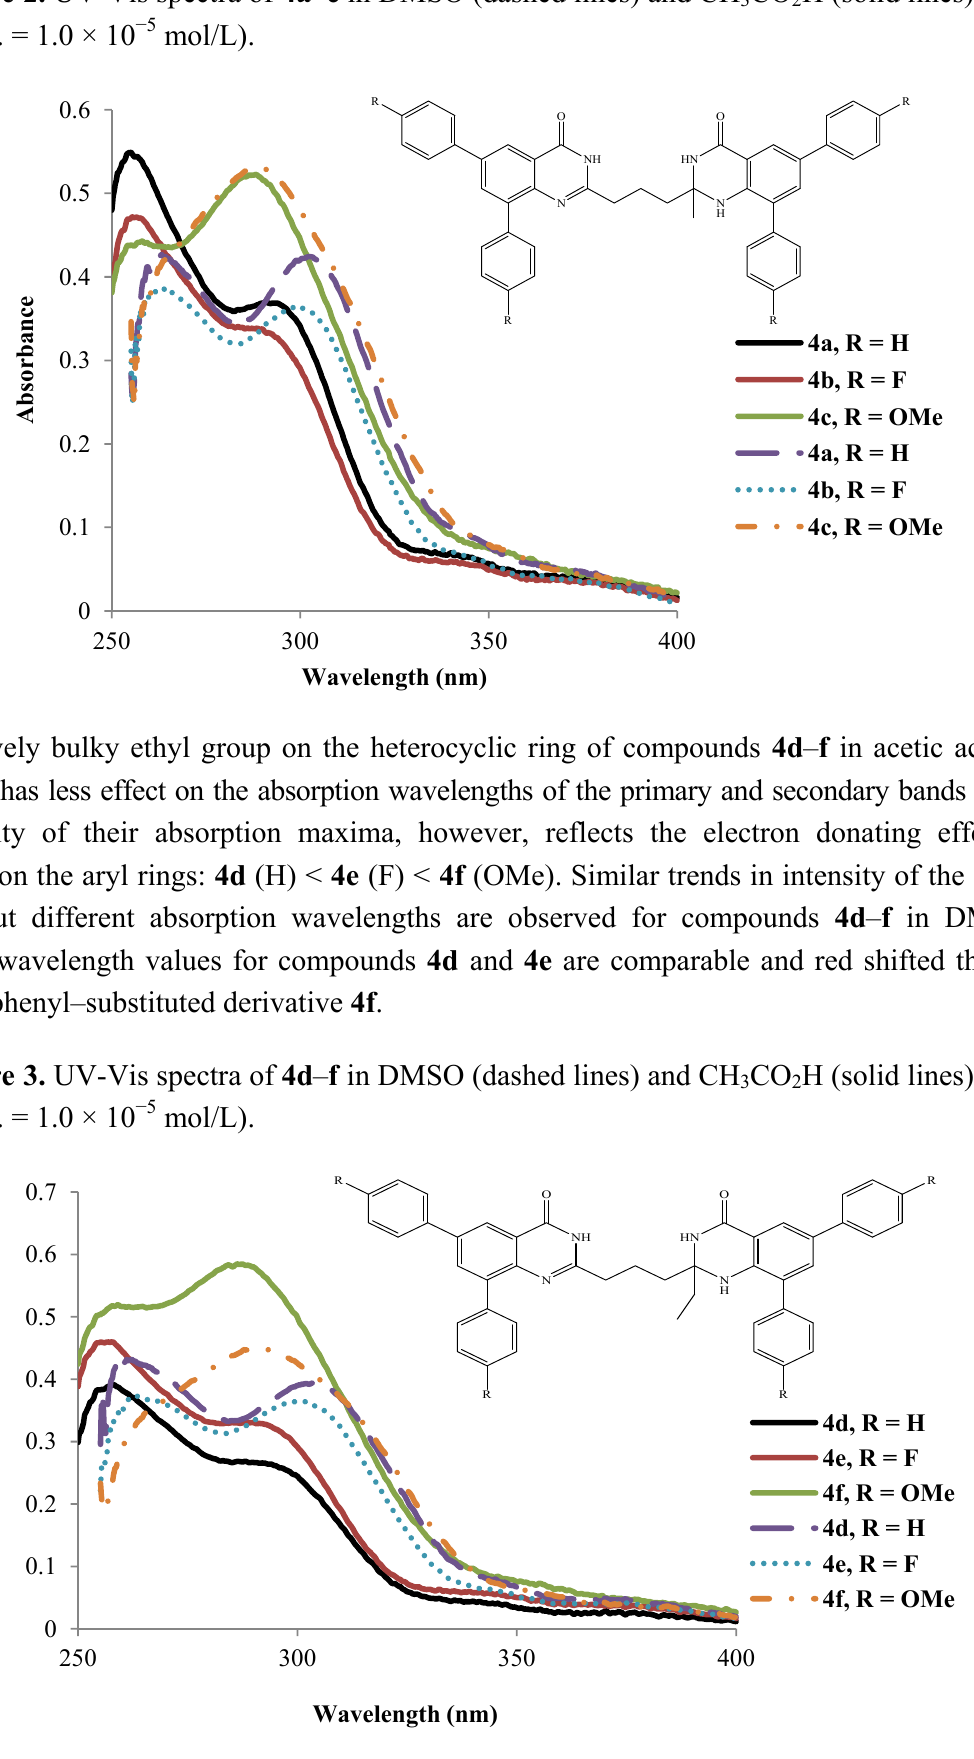
CO H (solid lines) at rt 3 2